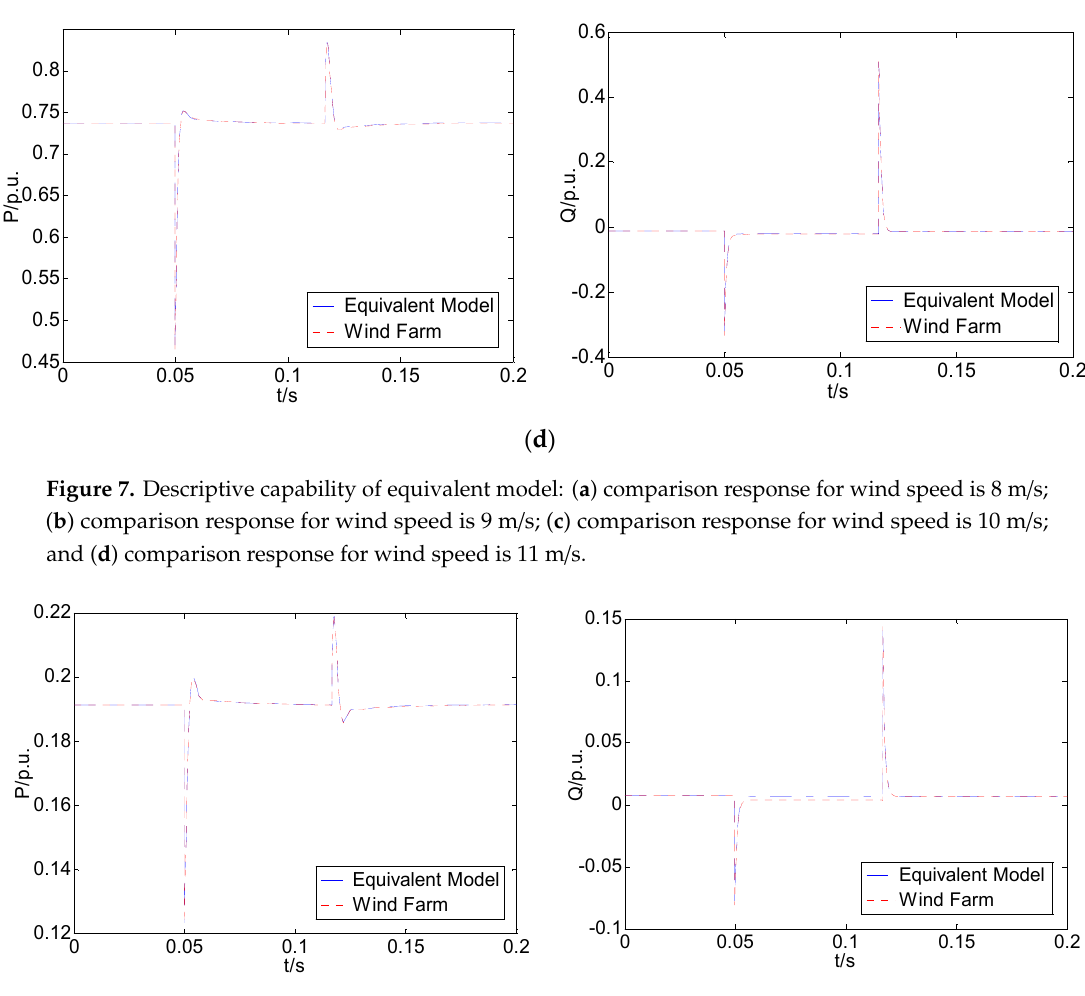
Figure 7. Descriptive capability of equivalent model: ( a ) comparison response for wind speed is 8 m/s; ( b ) comparison response for wind speed is 9 m/s; ( c ) comparison response for wind speed is 10 m/s; and ( d ) comparison response for wind speed is 11 m/s.